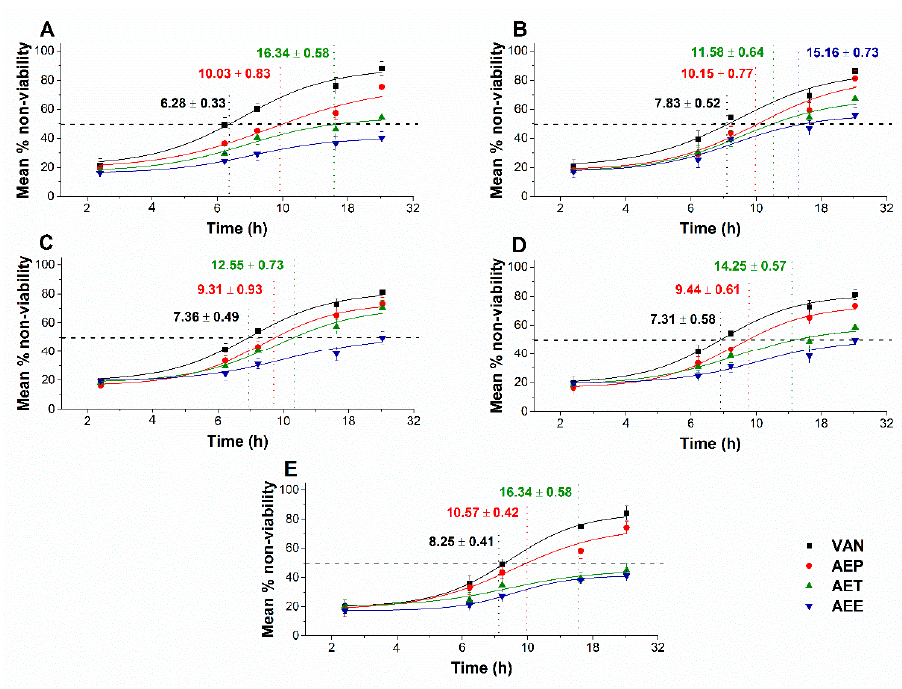
Figure 13. Mean percentage non-viability of AEP, AET and AEE at their MEC 10 concentrations on the metabolic activities of the planktonic E. coli ( A ), S. aureus ( B ), B. subtilis ( C ), P. aeruginosa ( D ), and S. pyogenes ( E ) compared to their respective 0 h samples and vancomycin (VAN) standard antimicrobial controls after 2, 6, 8, 16 and 24 h of treatment (mean ± SD, n = 6 independent experiments each with three technical replicates).